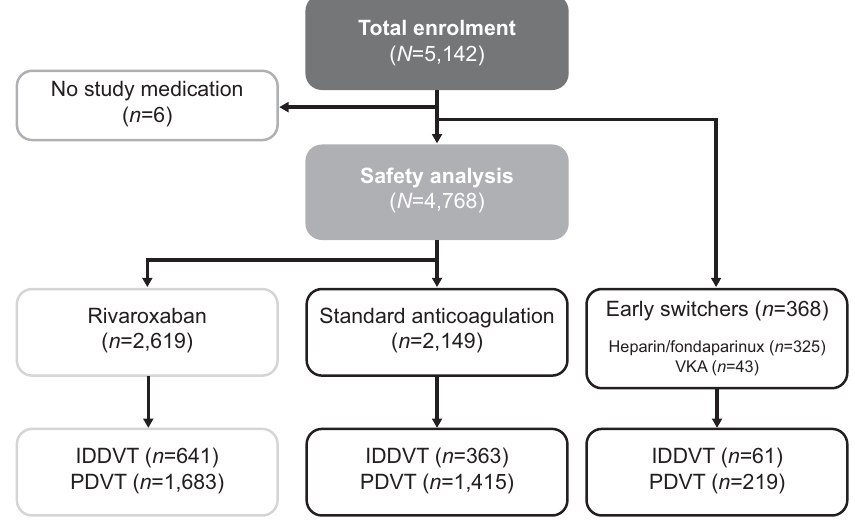
Fig. 1 Patient fl ow through the study. Abbreviations: IDDVT, isolated distal deep-vein thrombosis; PDVT, proximal deep-vein thrombosis; VKA, vitamin K antagonist; VTE, venous